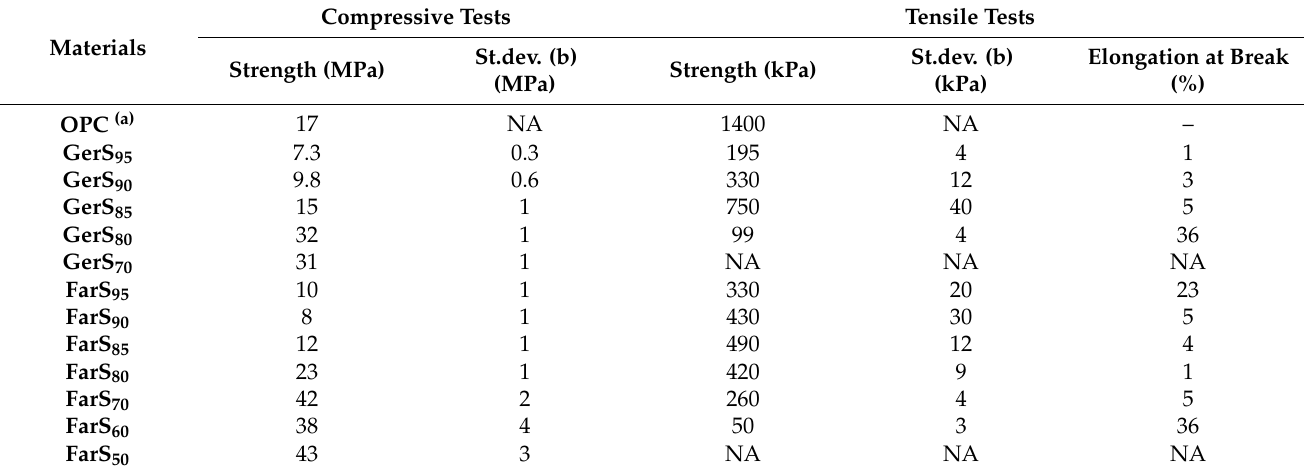
Table 2. Mechanical properties of terpenoid-sulfur